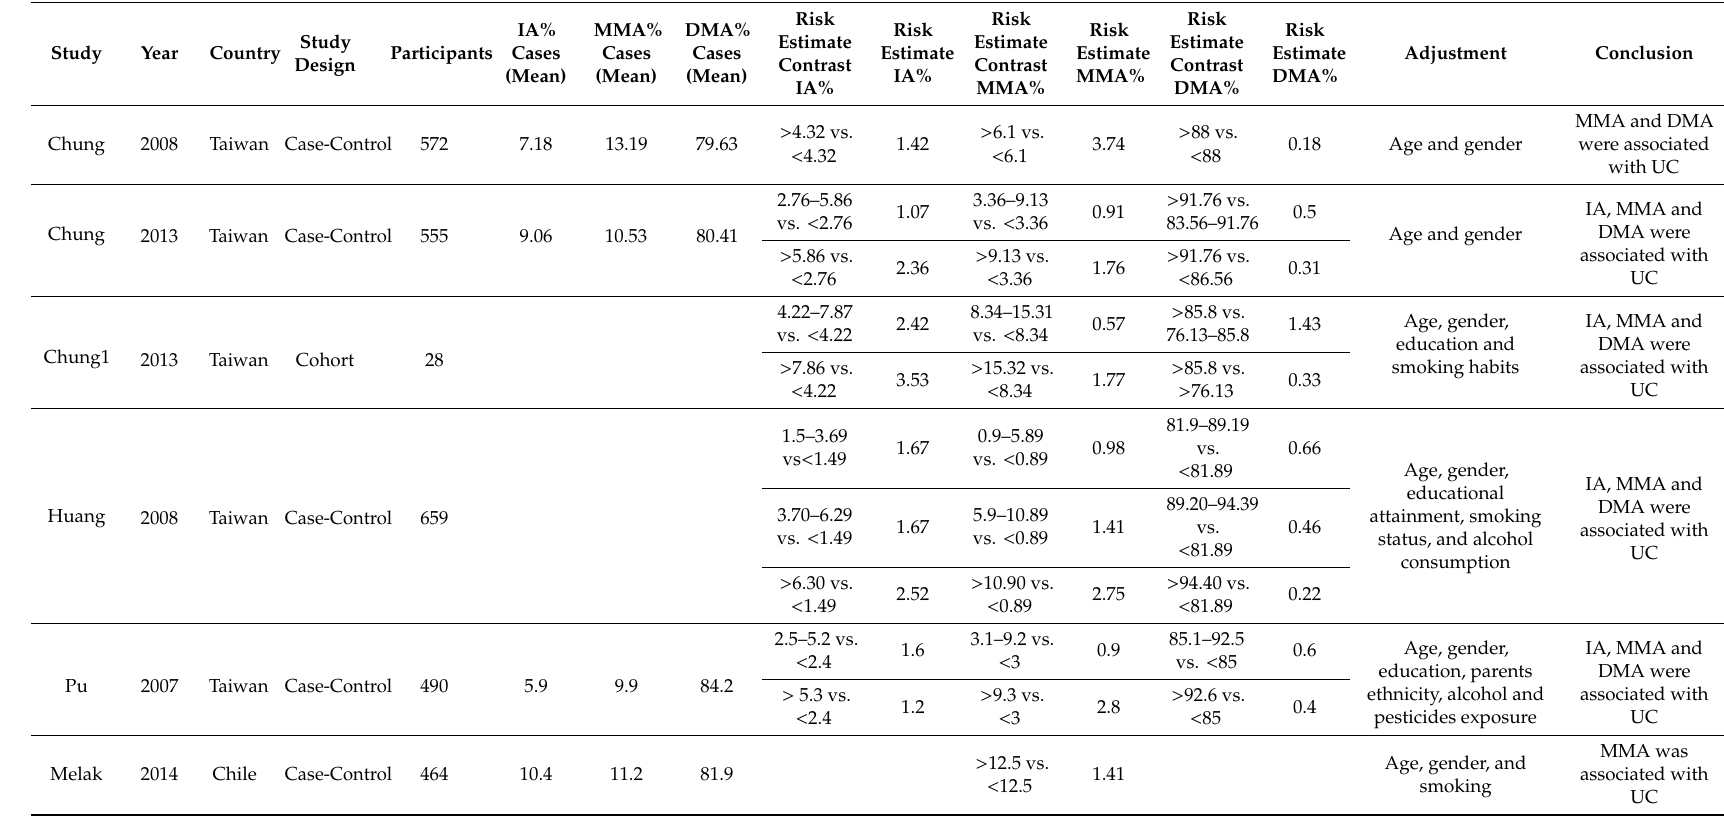
Table 1. Characteristics of included